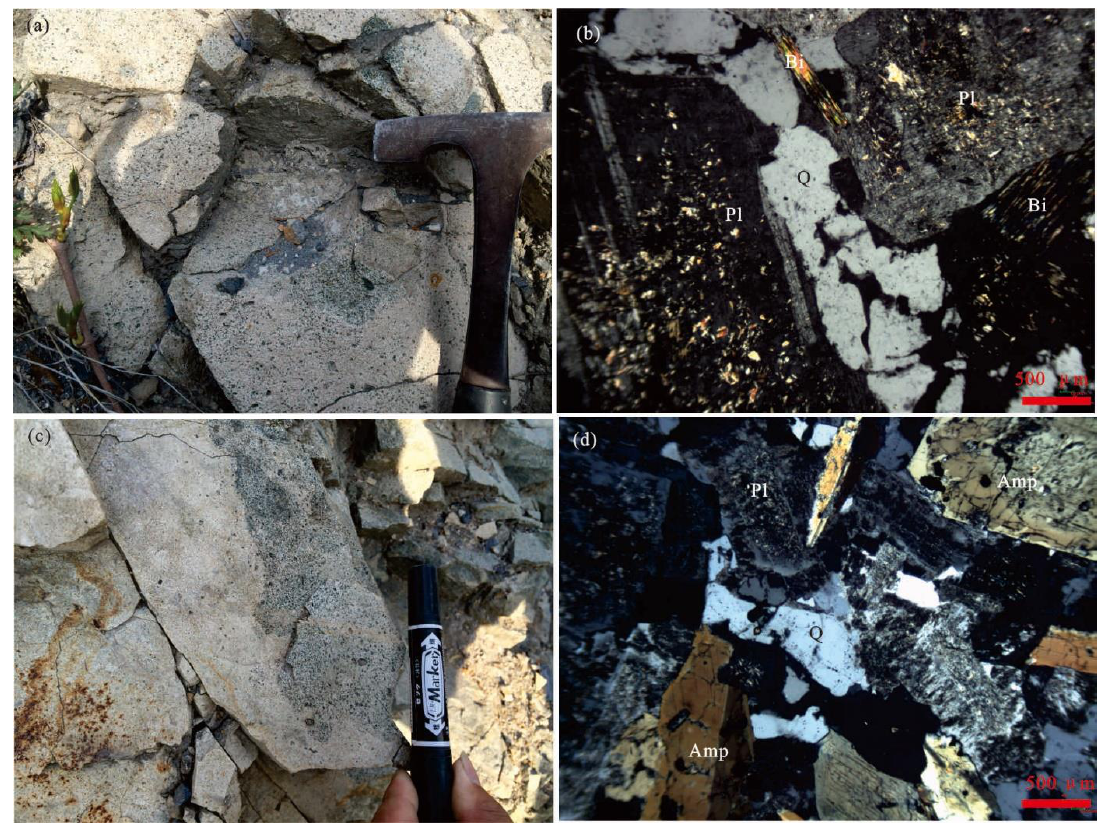
Figure 2. Petrological features of Quartz monzonites in the Jinling area, western Shandong province. ( a , b ) — HS4, quartz monzonites; ( c , d ) — HTS3, quartz monzonites.Q — Quartz; Bi — Biotite, Amp — Amphibole, Pl — Plagioclase.